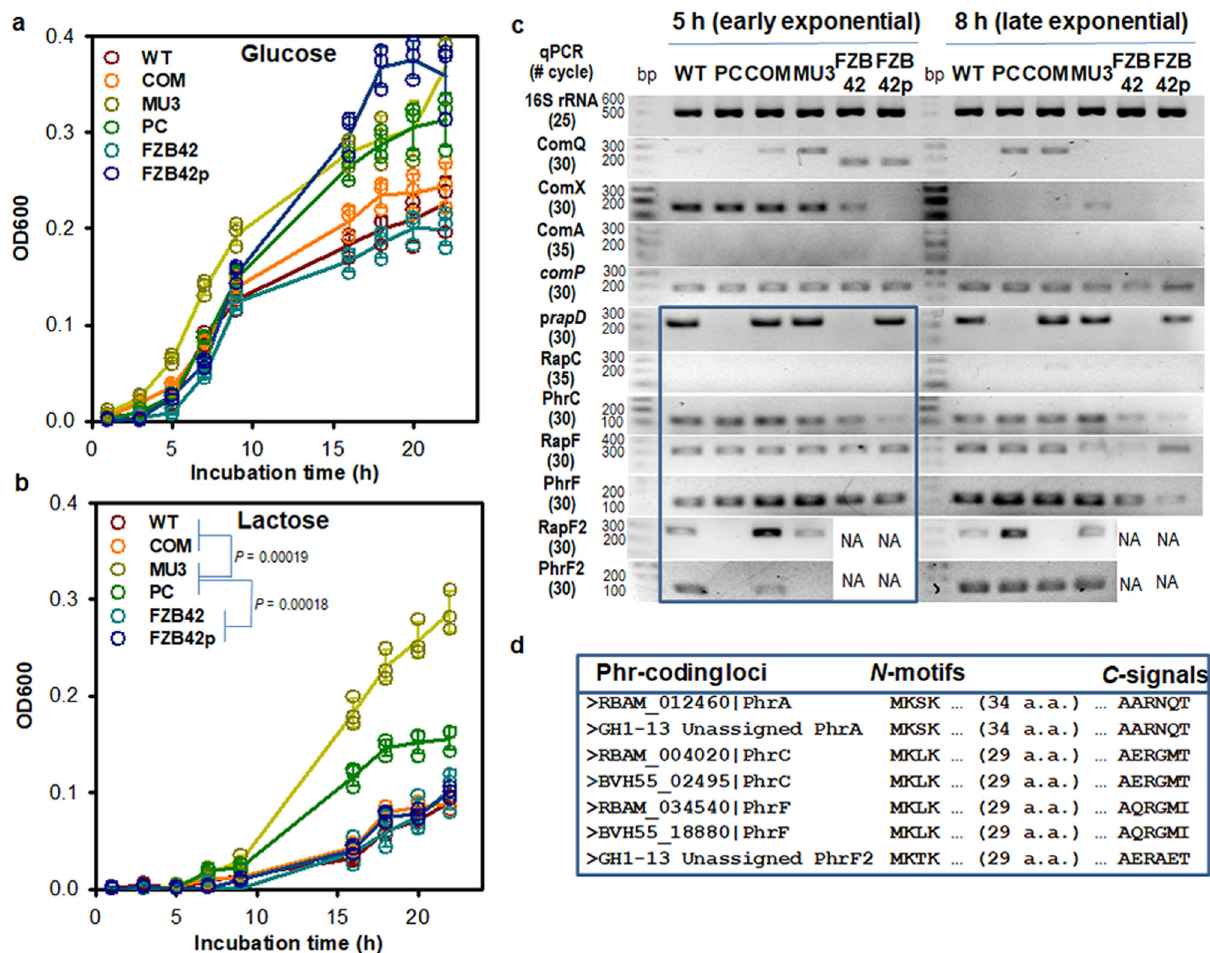
Fig. 5 Growth curve and gene expression patterns of non-mucoid and mucoid phenotypes of strains GH1-13 and FZB42 with or without pBV71. a , b Growth curves of WT strain GH1-13, mucoid variants MU3 and PC, a reverse complement COM, WT strain FZB42, and the transconjugant FZB42p cells on glucose ( a ) and lactose ( b ) at the fi nal concentration of 0.2% (w/v) in M9 media. A statistically signi fi cant difference between the growth rates of cells of the non-mucoid and mucoid phenotypes with lactose used as the sole carbon and energy were determined by two-tailed t -tests with P -values < 0.05, from comparative tests for 6 sole carbon sources (glucose, lactose, maltose, sucrose, galactose, and glycerol) as shown in Supplementary Fig. 3. n = 3 independent experiments (Supplementary Data 3). The mean and standard deviation (error bar) are plotted for all graphs. c Semi-quantitative RT-PCR results show variations of the transcription of the quorum-sensing ComQXAP and Rap-Phr systems with expression levels of prapD in pBV71 in non-mucoid and mucoid variants of strains GH1-13 and FZB42 with or without pBV71. The uncropped gel images are shown in Supplementary Fig. 12. Expression levels of p rapD and chromosomal rap – phr genes at the early exponential phase (5 h culture) of the cells are highlighted in the blue box. NA, rapF2 – phrF2 genes not available in strain FZB42. d Aligned amino acid sequences of N -terminal translation initiation sites and C -terminal pheromone peptide signals deduced from the coding regions of strains GH1-13 and FZB42. In strain GH1-13, PhrA, and PhrF2 sequences are categorized by a manual curation